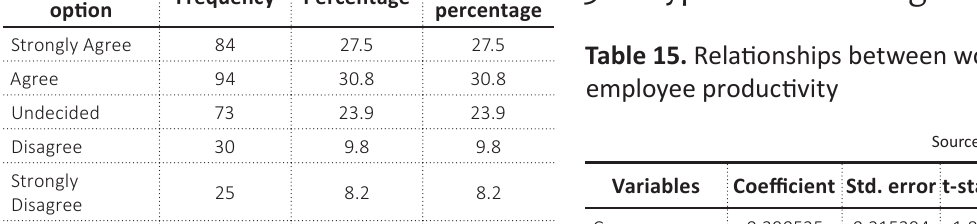
Table 15. Relationships between work stress